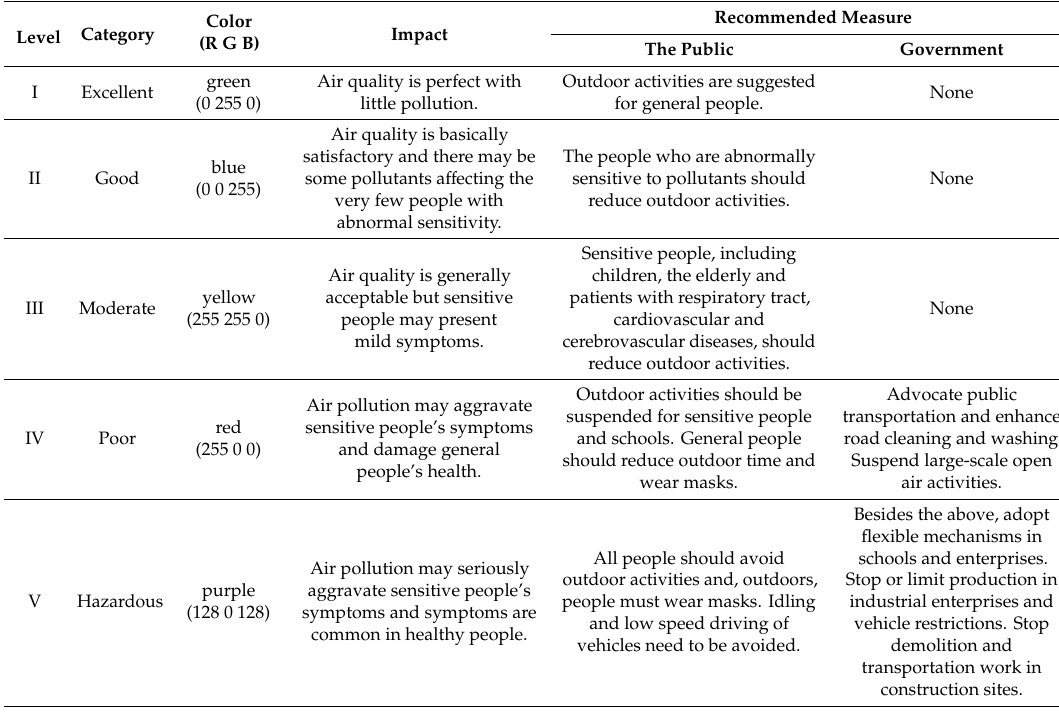
Table 4. Air pollution early